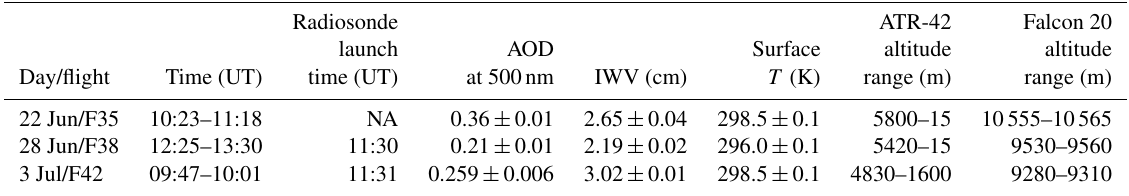
Table 1. Summary of the time intervals, average (with standard deviation) AOD at 500nm, IWV, and surface temperature during the descent portion of the three flights selected for this study. The altitude ranges of the ATR-42 and Falcon 20 observations are also shown. NA stands for “not available”. Radiosonde ATR-42 Falcon 20 launch Surface altitude